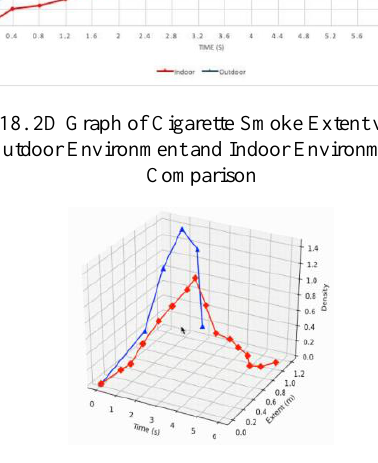
Figure 19. 3D Graph of Cigarette Smoke Density vs Time vs Extent Relative from the Source for Both Indoor